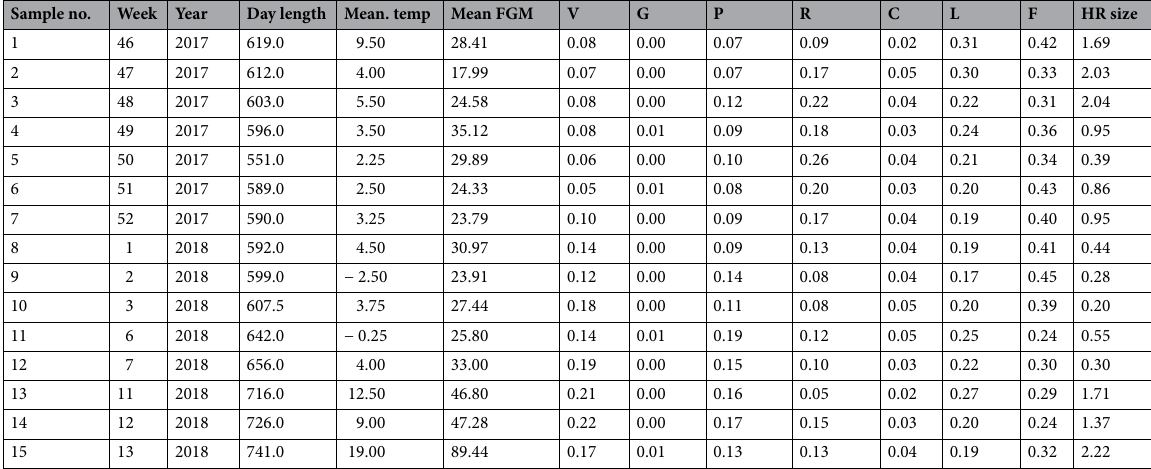
Table 5. Sample number, week of the year, year and the extrinsic and intrinsic variables included in the weekly sampling scheme of wintering whooper swans in Sanmenxia Swan National Wetland Park (daily data were pooled and averaged for each week): photo period (day length in minutes), mean weekly air temperature (°C), mean fecal glucocorticoid metabolite (FGM) concentration (pg/ml), home range (HR) size (km 2 ) and the frequency of seven behaviors: vigilance (V), fighting (G), preening (P), resting (R), calling (C), locomotion (L) and foraging (F).